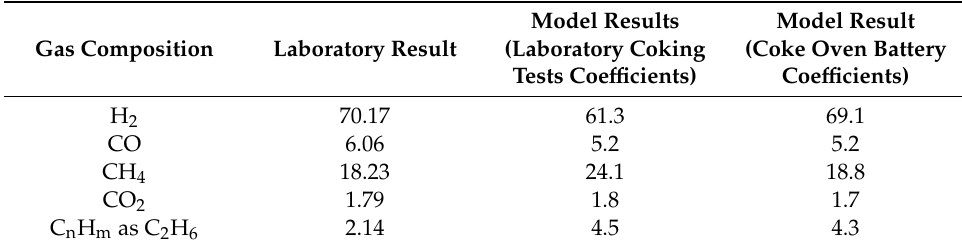
Table 9. The chemical composition of raw coke oven gas, % vol